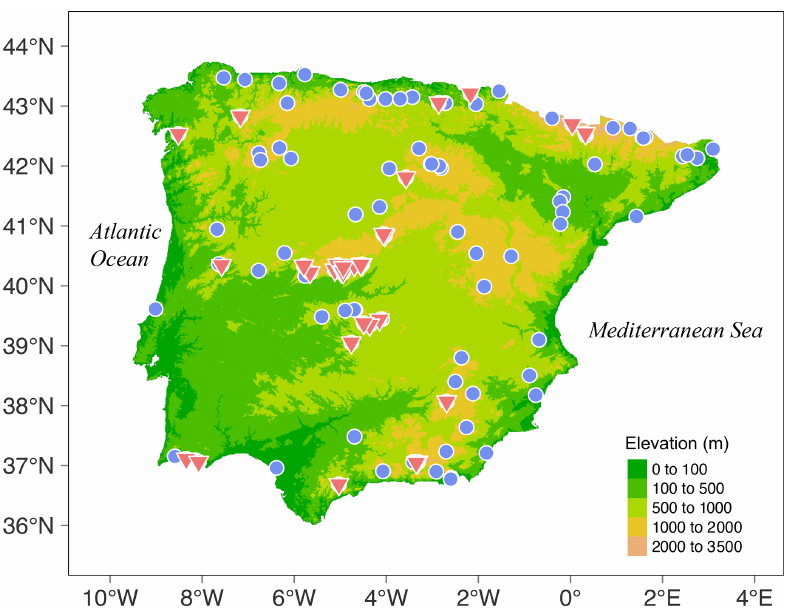
Figure 2. Map showing the location of the 31 entities (31 sites) with modern charcoal used to derive the fire–vegetation relationship (red triangles) and the 113 entities (111 sites) used for burnt area reconstructions (blue circles) in the Iberian